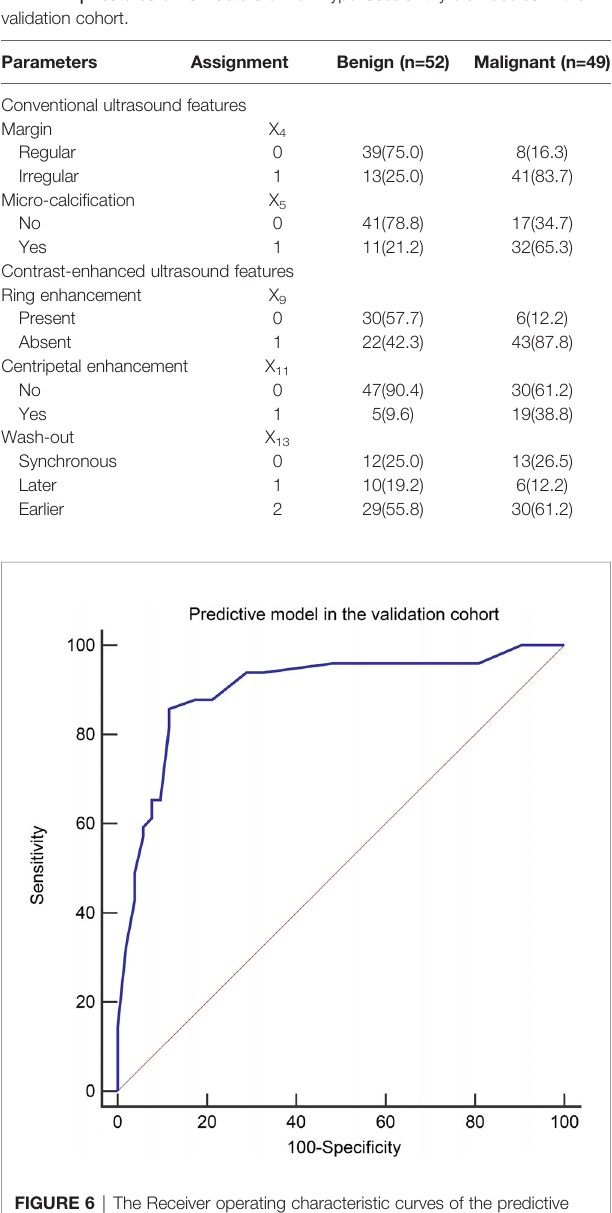
FIGURE 6 | The Receiver operating characteristic curves of the predictive model in the validation cohort (AUC=0.900).